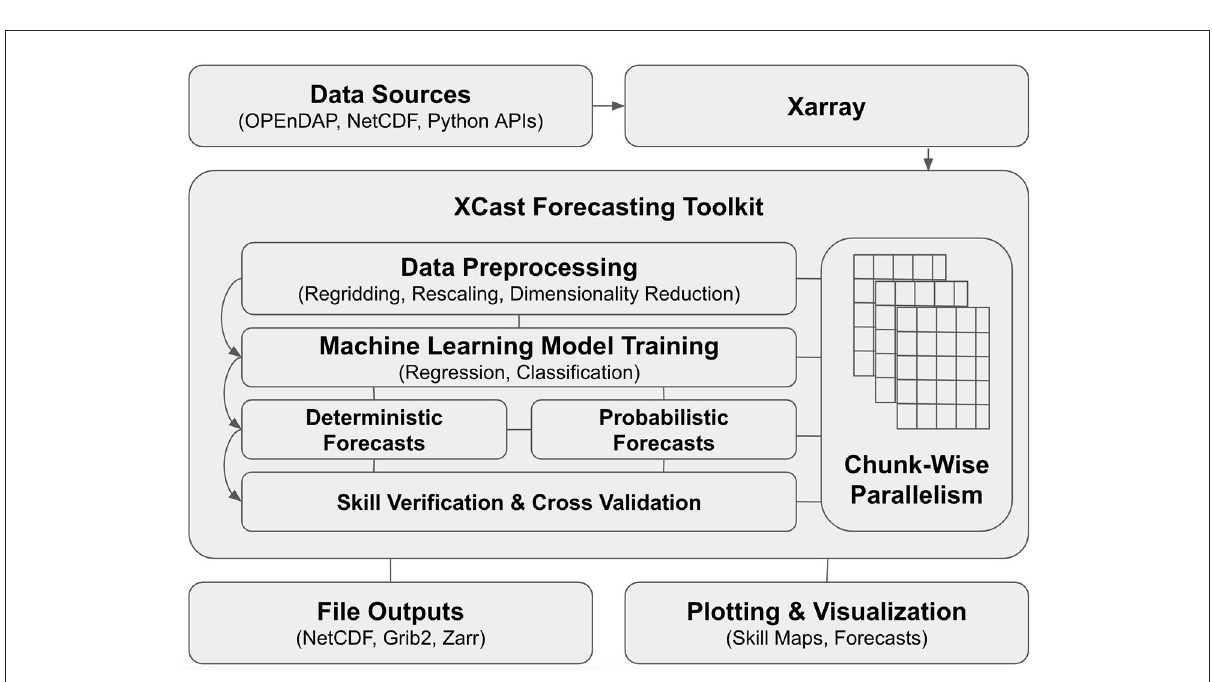
FIGURE2 The workflow of the XCast Toolkit.